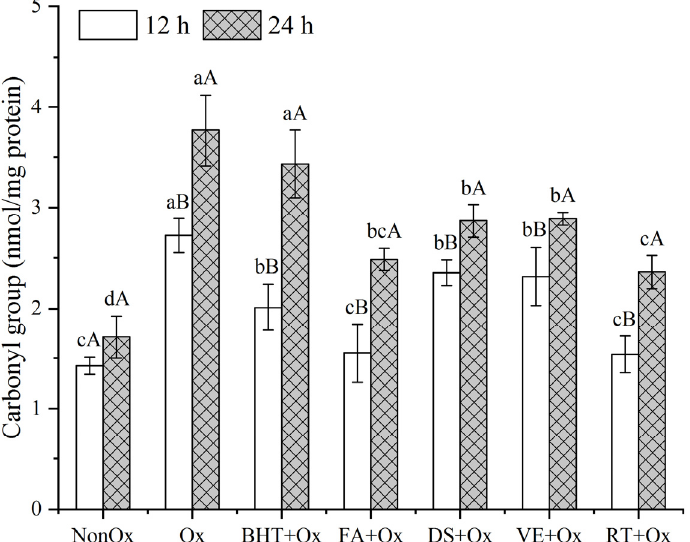
Figure 2. Protein carbonyl content of MPs in minced yak meat supplemented with different antioxidants. Note: NonOx—non-oxidized; Ox—oxidized without antioxidant; BHT + Ox, FA + Ox, DS + Ox, VE + Ox, and RT + Ox—oxidized in the presence of BHT, ferulic acid, diallyl sulfide, α -tocopherol, and rutin, respectively. a–d Means with different lowercase letters are significantly different among antioxidant treatments for the same oxidation time ( p < 0.05); A–B Means with different uppercase letters are significantly different between 12 and 24 h for the same antioxidant treatment ( p < 0.05).